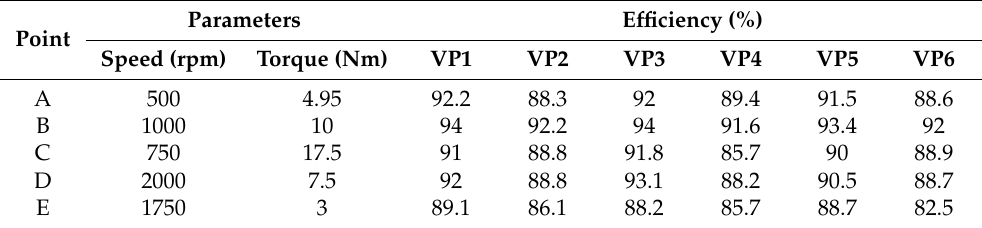
Table 8. Efficiency maps’